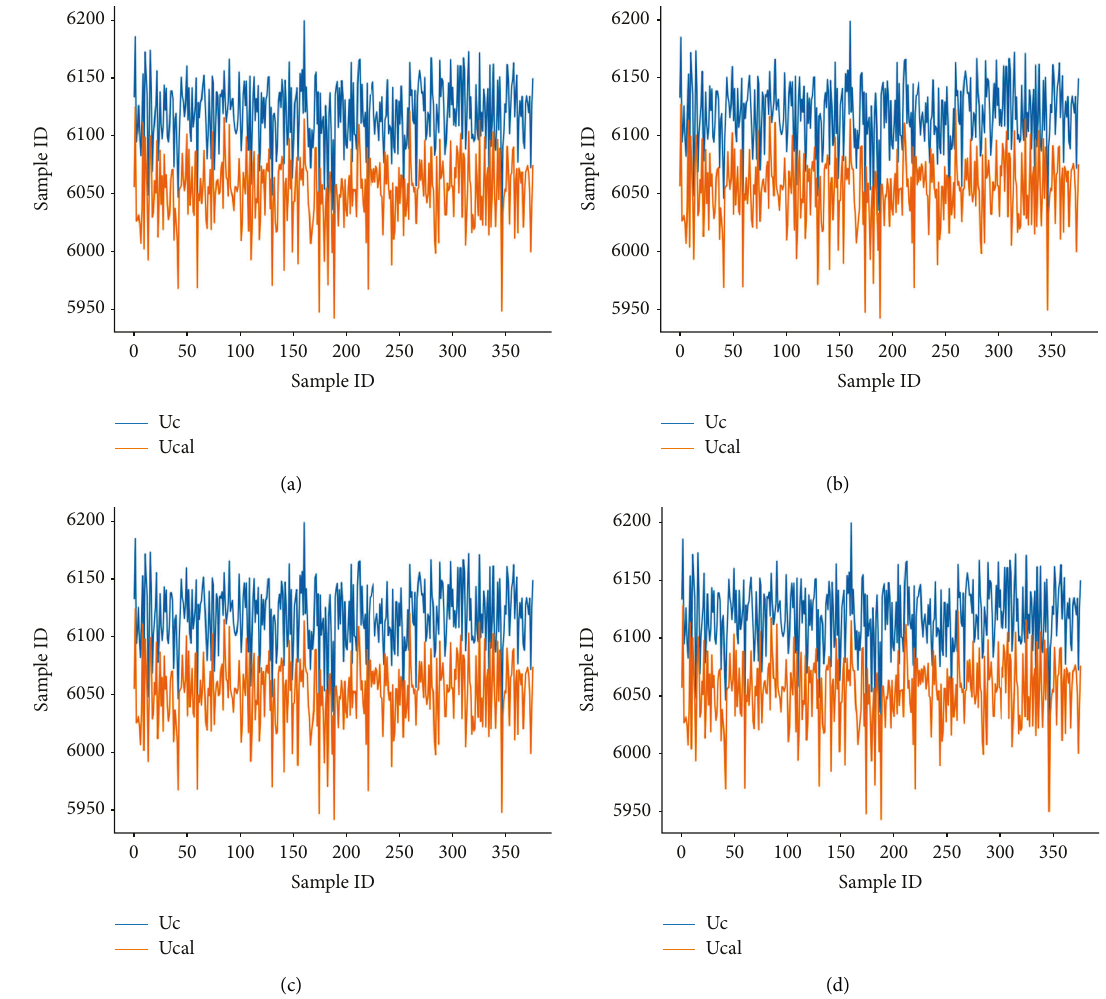
Figure 7: The line plot of U